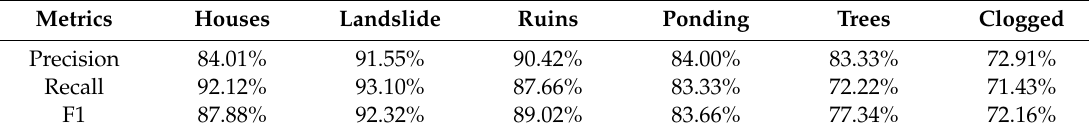
Table 9. Test results of the optimal PEMSR model. This model is trained after data augmentation by a factor of 8 and data balancing.